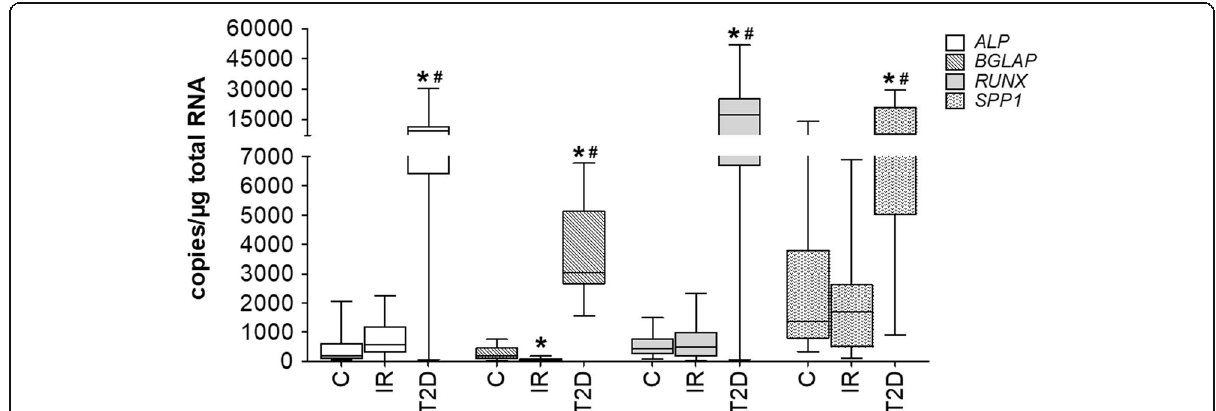
Fig. 5 The mRNA levels of BGLAP, ALP, SPP1, RUNX2 in the ADSC from patients with insulin-resistance (IR), type 2 diabetes (T2D) compared to control cells (C) from healthy people after osteoblast differentiation. The bars represent the (Me) with the 25 th and 75 th quartiles and the minimum and maximum of the copy numbers per 1 μ g of total RNA; the Kruskal Wallis test with post hoc, * p < 0.05 vs. C, # p < 0.05 vs. IR